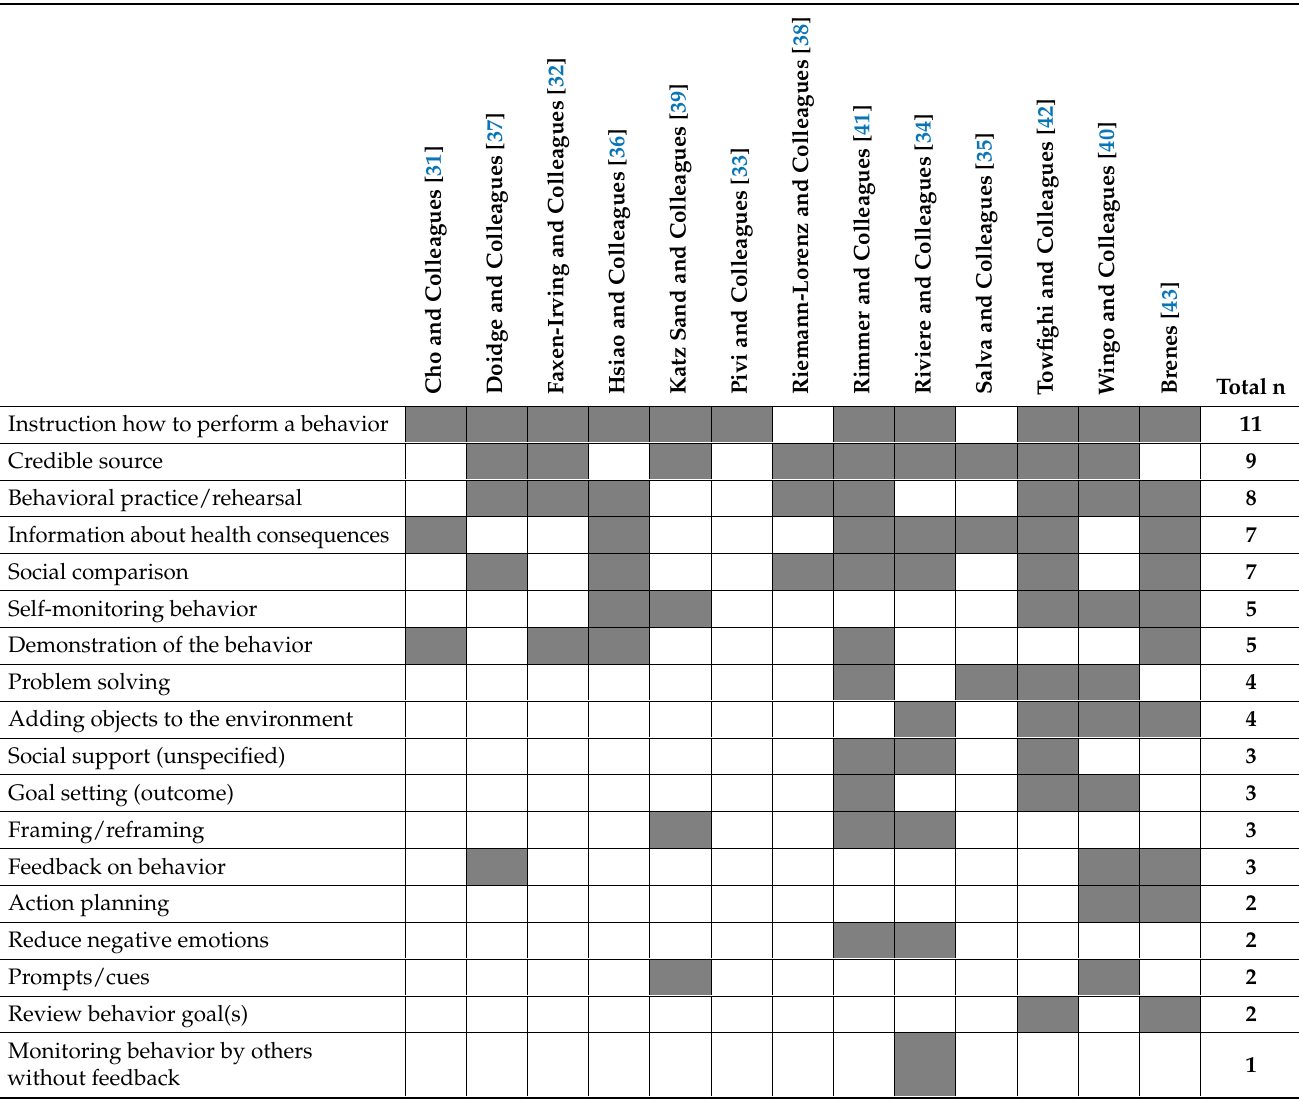
Table 2. Behavior change techniques used in each of the 13 studies that met the inclusion criteria of a scoping review of nutrition education programs for adults with neurological